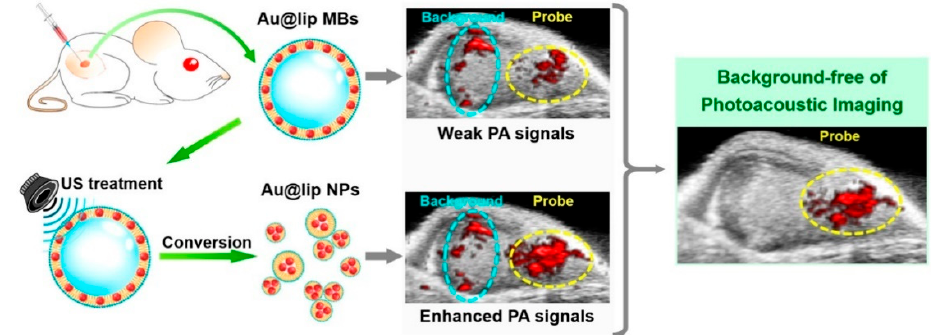
Figure 8. Schematic illustration of the ultrasound-responsive Au@lip MBs used for in vivo photoacoustic imaging with minimal background. Reproduced with permission from the publisher of corresponding reference [154].